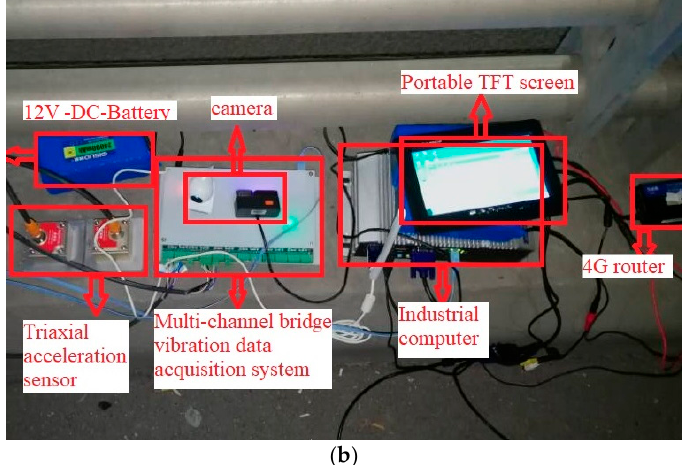
Figure 16. Bridge site data collection physical map: ( a ) Overall view of the bridge; ( b ) Field data collection physical map.